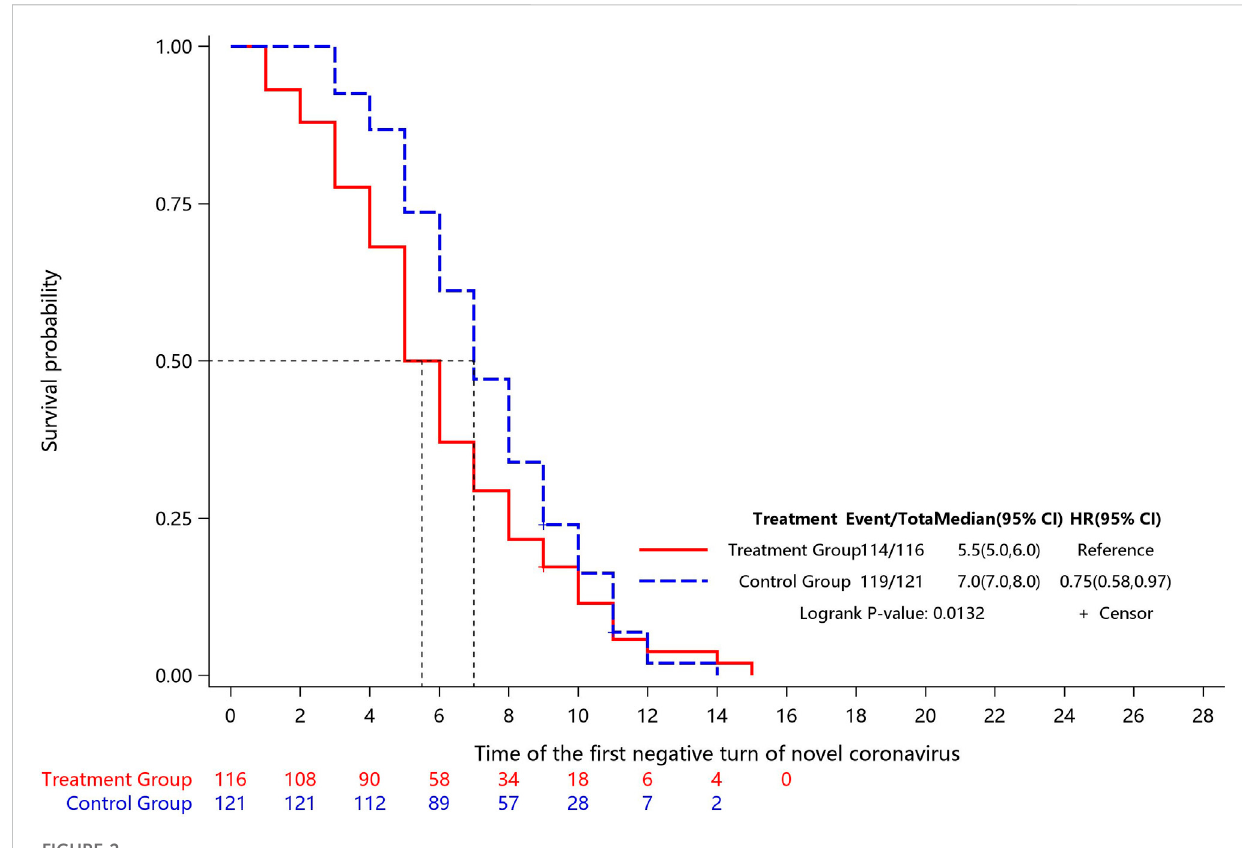
FIGURE 2 Kaplan-Meier survival curve of the time to fi rst negative viral testing